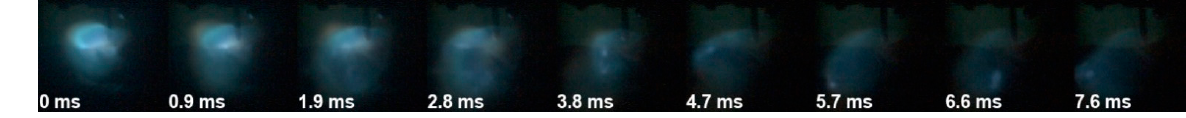
Figure 7. CSC cathode spot wandering.